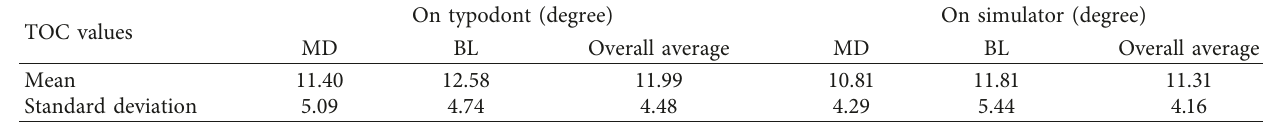
Table 1: Average TOC of typodont and simulator preparations.